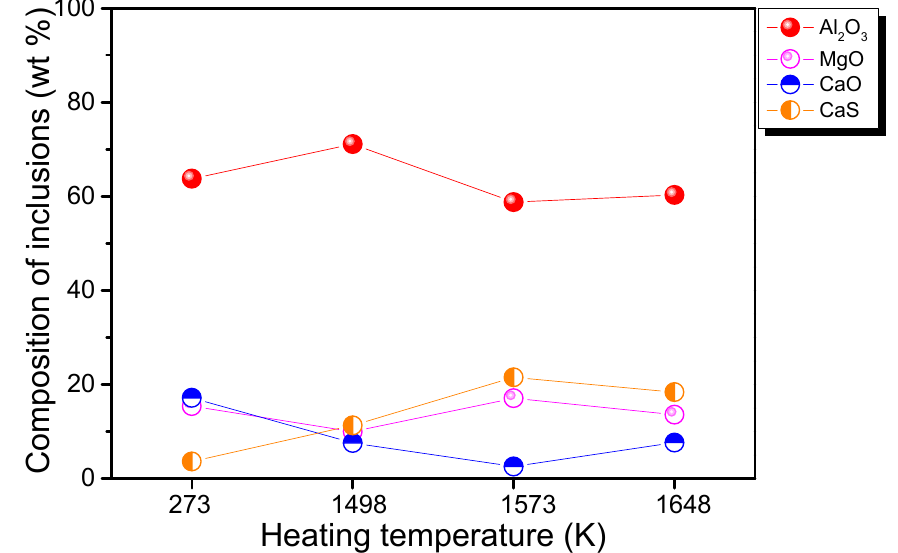
Figure 14. Effect of holding time on the average composition of inclusions in the steel during annealing at 1648 K.